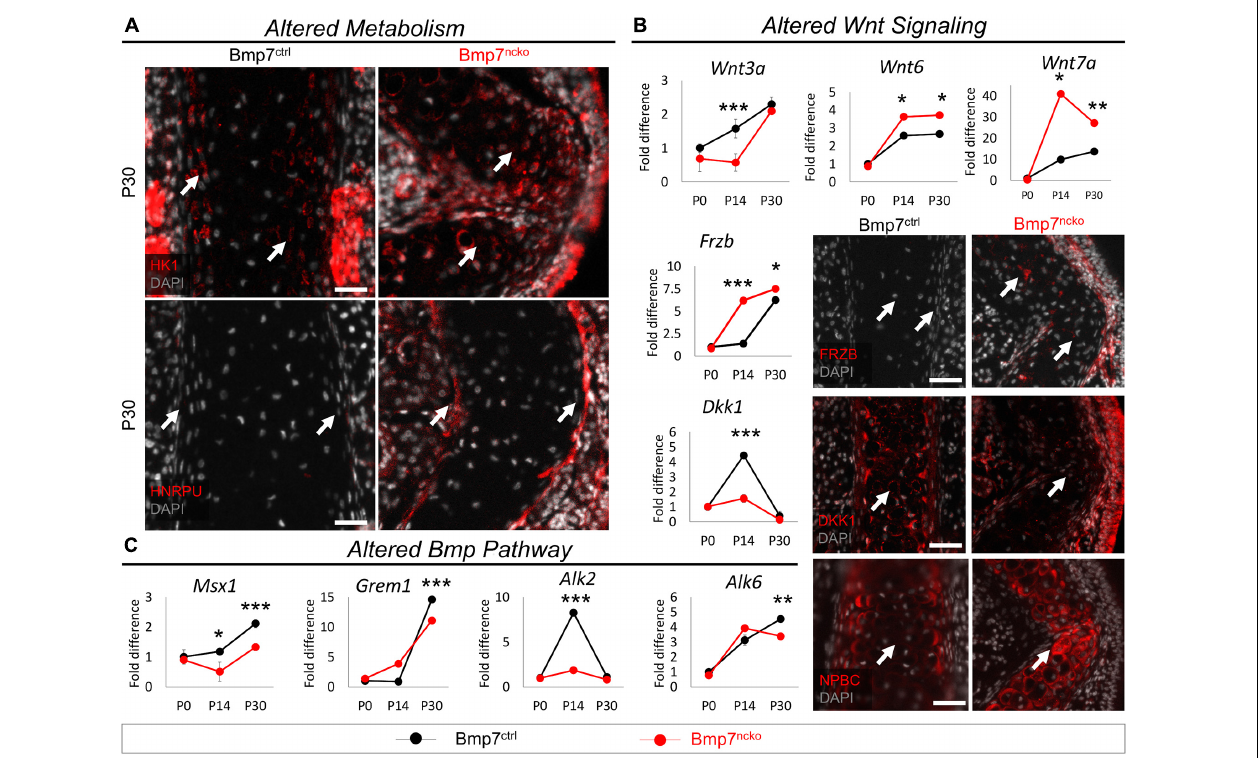
FIGURE 5 | Altered metabolism and Wnt signaling in P30 Bmp7 ncko mice. (A) Immunofluorescence staining of Hexokinase (HK1) and Heterogeneous nuclear ribonucleoprotein U (HNRPU) in P30 Bmp7 ctrl and Bmp7 ncko mice revealed an increase in expression of both proteins in the mutant mice. (B) qRT-PCR of dissected nasal septum at P0, P14 and P30 timepoints demonstrating differential gene expression of Wnt ligands (WNT3A, WNT6, WNT7A) and Wnt antagonists (FRZB, DKK1). Immunostaining of Wnt antagonists (FRZB, DKK1) in P30 Bmp7 ctrl and Bmp7 ncko mice demonstrate an increase in expression of FRZB and decrease in DKK1 expression in the mutant mice. Immunofluorescence staining using Non-phosphorylated Beta-Catenin (NPBC) in P30 mice demonstrates nuclear expression in Bmp7 ncko and cytoplasmic expression in Bmp7 ctrl mice. (C) qRT-PCR of nasal septum at P0, P14, and P30 ages revealed alterations to genes in the Bmp pathway (MSX1, GREM1, ALK2, ALK6). Independent two-tailed t -test was performed with significance denoted as *: p < 0.05, **: p < 0.01, ***: p < 0.001. ( n = 3/genotype/age). Antibody expression demonstrated in red and DAPI stained nuclei in gray for all immunofluorescence images. Arrows denoting positive antibody signal. Scale bar = 50 µ